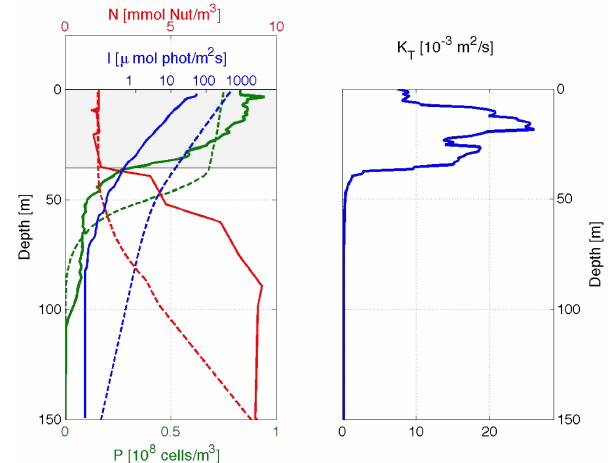
Figure 7. Measurements (solid lines) and model results (dashed lines) at the transition station. See caption of Fig. 6 for